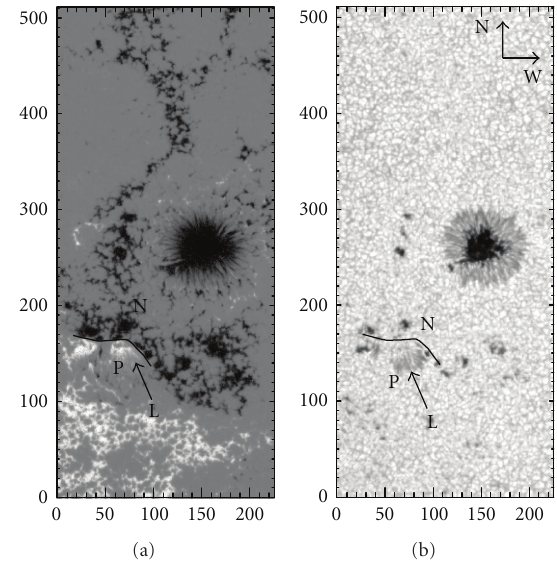
Figure 2: A map of line-of-sight component of the magnetic field (a) and the corresponding continuum image (b) obtained from spectropolarimeter onboard Hinode on June 06, 2007 at 22:57 UT. The arrow indicates the position of PLFs. P and N represent the positive and negative polarity regions. A dark line between negative and positive polarity represents the position of the polarity inversion line. The scales are in unit of